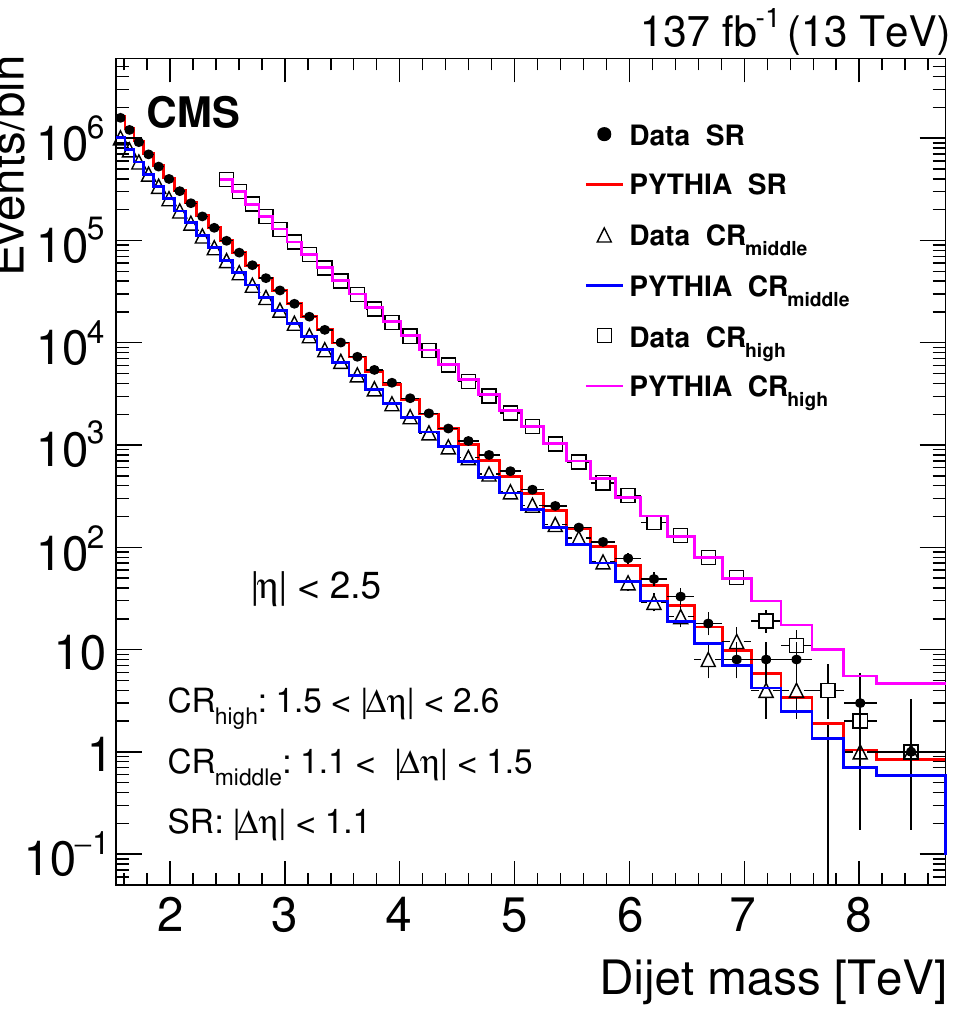
Figure 2 . The dijet mass spectra of the data and pythia simulation in the signal region at low j (cid:1) (cid:17) j (black points and red histogram), control region at middle j (cid:1) (cid:17) j (triangles and blue histogram), and control region at high j (cid:1) (cid:17) j (squares and magenta histogram). The simulation is normalized to